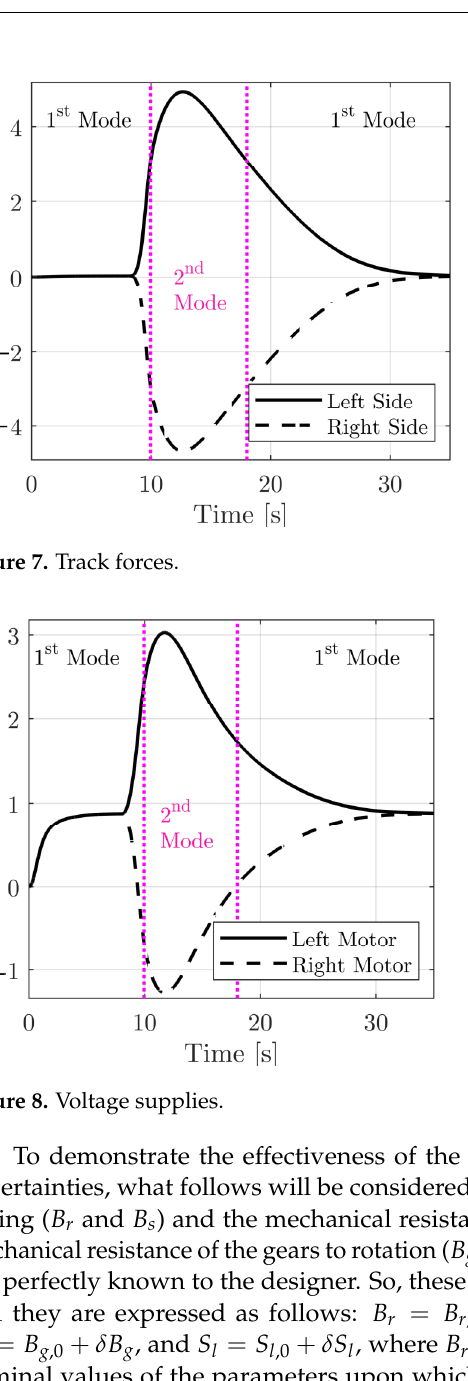
Figure 6. Motor angular velocities.